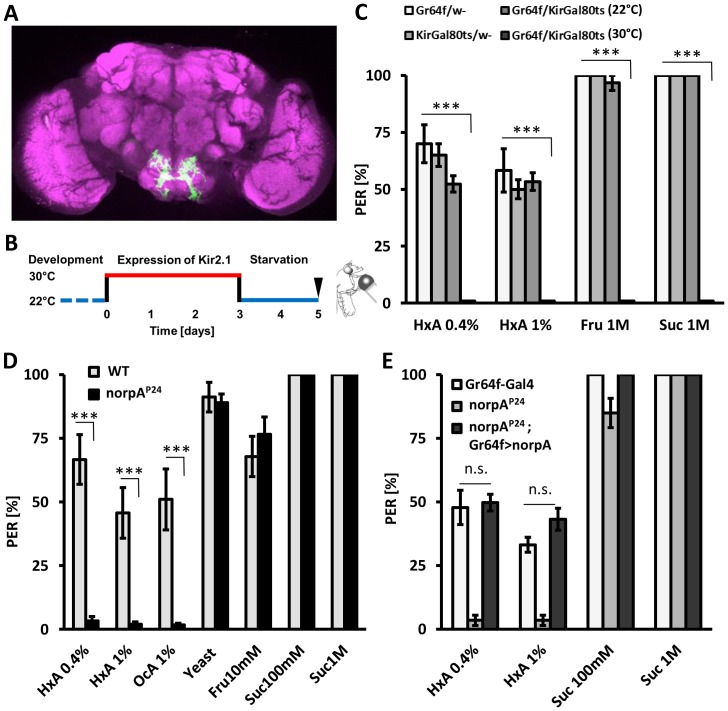
Fatty acids taste requires intact PLC signaling specifically in sugar-sensing neurons.A) Expression of GFP under the control of Gr64f-GAL4 (green). Neuropile regions are labeled by nc82 antibody (magenta). The sweet-sensing neurons ramify throughout the suboesophageal ganglion. B) Specific neurons are silenced by expression of Kir2.1-GAL80ts at 30°C during adulthood. C) PER response to HxA is abolished with adult-specific silencing of sugar-sensing neurons (Gr64f). Flies with silenced Gr64f neurons (Gr64f-GAL4>Kir2.1-GAL80ts at 30°C) showed significantly reduced PER compared to control flies harboring either UAS-Kir2.1;GAL80ts or Gr64f-GAL4 alone or to flies with not activated Kir2.1 (Gr64f-GAL4>Kir2.1GAL80ts at 22°C) (p<0.001). D) norpA
P24 mutant flies are deficient in sensing HxA but respond normally to water and other tastants including yeast, fructose, and sucrose. E) Restoring norpAP24 function selectively in Gr64f neurons by expressing the norpA transgene under control of Gr64f-GAL4 (Gr64f-GAL4>UAS-norpA) rescues PER response to HxA compared to mutant control (norpA
P24;+) (p<0.001) to the level of control carrying intact norpA allele (Gr64f-GAL4/+) (p>0.05). All data, mean ± s.e.m. *** p<0.001; NS, not significant, t-test.